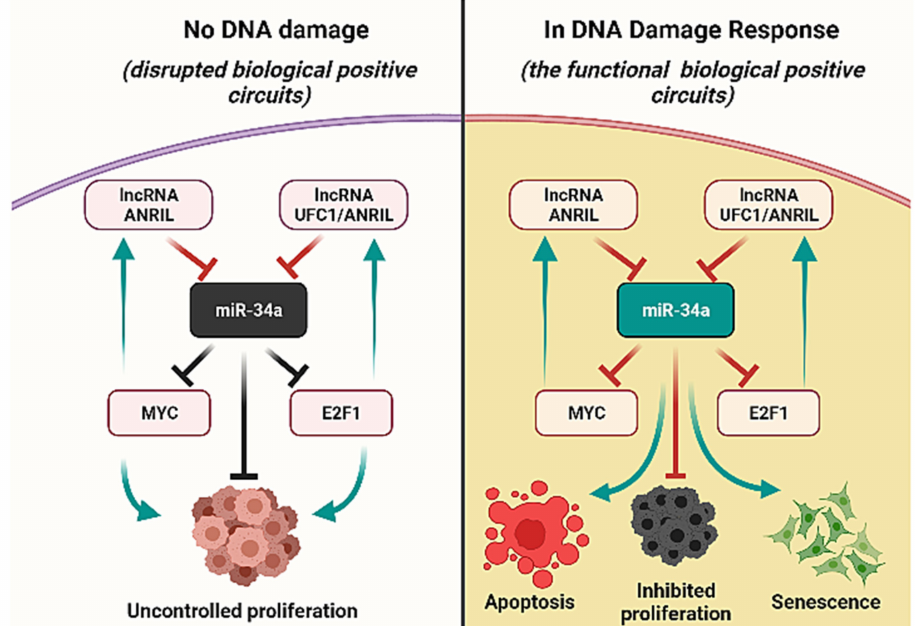
Figure 6. Functional Versus Disrupted positive circuits in NSCLC. The left-hand side: disrupted positive circuits due to the lack of DNA damage in NSCLC cells, i.e., inactivation of miR-34a expres- sion, consequently promoting uncontrolled proliferation. On the Right-hand side: In response to DNA damage, the positive circuits between (miR-34a/Myc/lncRNA ANRIL, miR-34a/E2F1/lncRNA ANRIL, and miR-34a/E2F1/lncRNA UFC1) are stimulated. Activated miR-34a inhibits Myc and E2F1 i.e., inducers of lncRNA ANRIL and lncRNA UFC1. Targeting Myc and E2F1 by the miR-34a prevented tumor growth through the induction of senescence and apoptosis in NSCLC cells. In this way, these positive circuits playing an important role to inhibit proliferation in DNA damage response. Green Arrows represent activation, whereas red hammer-head arrows represent inhibition. Black hammer-head arrows represent non-functional/inactivation of miR-34a,